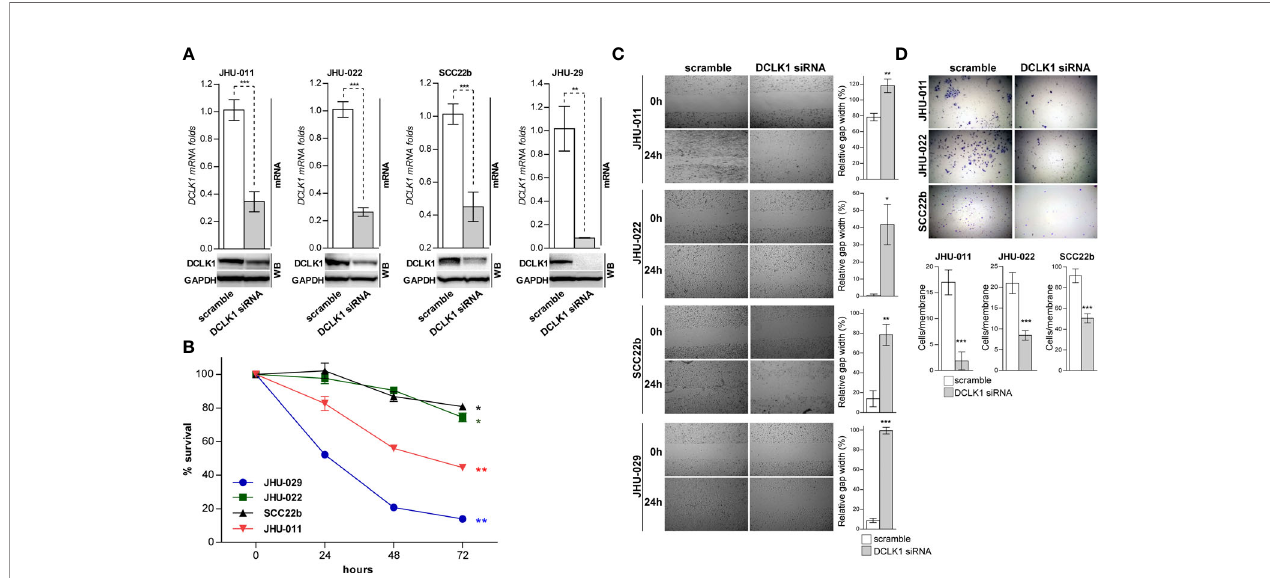
FIGURE 2 | siRNA mediated down regulation of DCLK1 leads to reduced growth, invasion and migration. (A) DCLK1 expression was knocked down in four indicated HNSCC cells using siRNA. Cell transfected with scramble non-targeting siRNA were used as controls. mRNA and whole cell lysates were prepared from DCLK1-depleted and control cells and analyzed by RT-PCR (top) and western blot (bottom) for the DCLK1 expression on RNA and protein levels. (B) DCLK1 depleted and control cells were plated at equal numbers in triplicates and relative cell viability was determined using an Alamar Blue assay at indicated times points. (C) DCLK1 depleted and control cells were trypsinized, counted, plated in triplicate in 6-well plates (1 x 10 6 cells per well) containing inserts and allowed to attach for 12 h. The inserts were removed and the gap was photographed immediately and after 12 h. Right panels - gap area in individual wells was measured using ImageJ and relative gap width percentage was calculated as the gap area at 12 h relative to the gap area at 0 h (*p < 0.05, **p < 0.01 and ***p < 0.001). (D) DCLK1 depleted and control cells were trypsinized, counted and cultured (1×10 4 cells per well) in triplicate into the transwell chambers. After 24 h the membranes were stained with crystal violet and cells that had migrated through the membrane were counted. Top panel - representative images are shown. Bottom panel - the average number of cells per fi eld that migrated through the membrane is shown as a bar chart (***p <